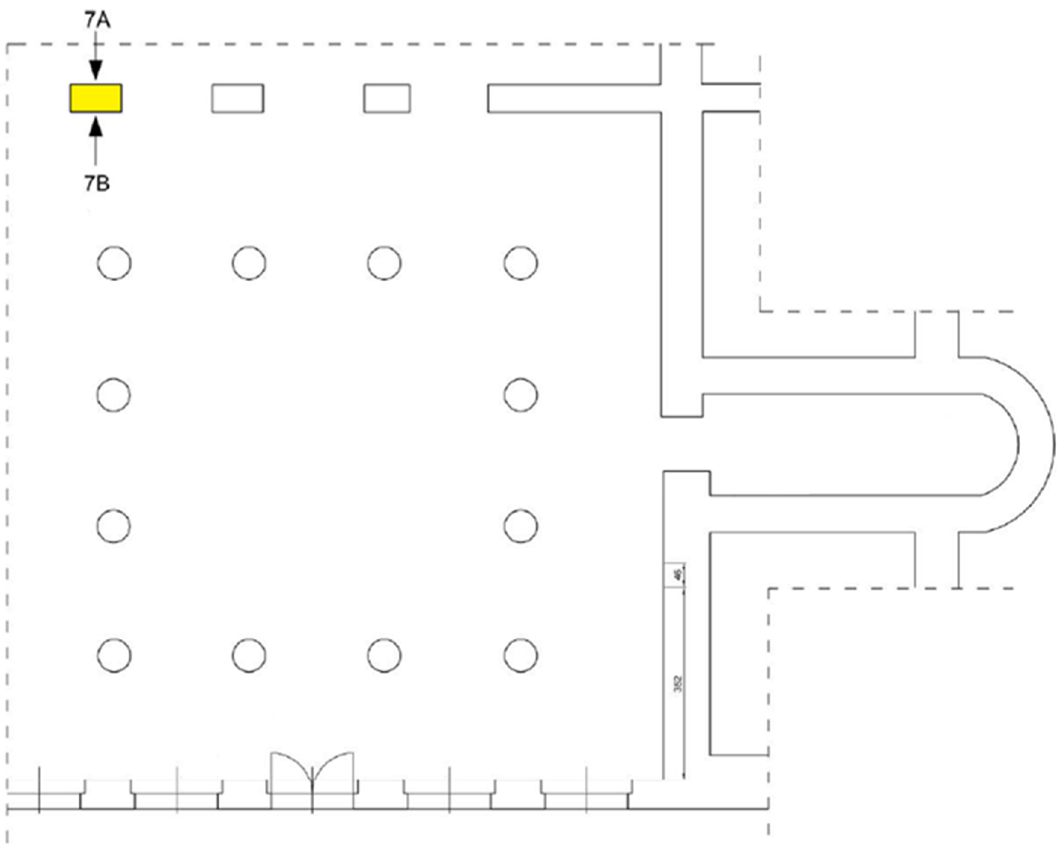
Figure 2. Arrangement of measurement spots on selected elements subjected to humidity tests. The tested pillar is marked in yellow. The arrows and the number-letter symbols indicate the spots and sides of the walls/pillars that were subject to the tests.